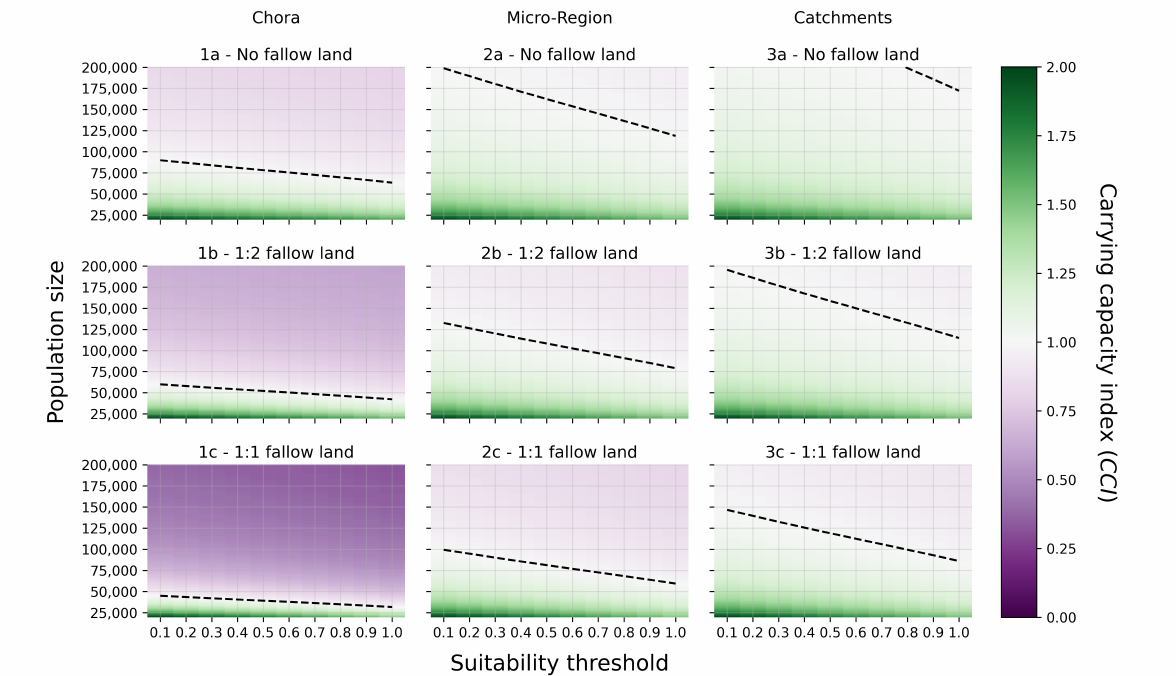
Figure 5. Carrying capacity estimation of the high labour scenario for the different heuristics of the Pergamon’s com- plementary area ( 1 chora; 2 Micro-Region; 3 catchment-based delineation), under three different fallow land scenarios ( a no fallow; b 1:2 fallow; c 1:1 fallow land) and 2100 kcal daily calorie requirements. Green colours ( CCI > 1.0) indicate that carrying capacity is not reached and enough land for cultivation is available. The opposite is true for purple colours ( CCI < 1.0); white ( CCI ≈ 1.0) indicates that the carrying capacity is met or almost met. The black line shows where the CCI is exactly